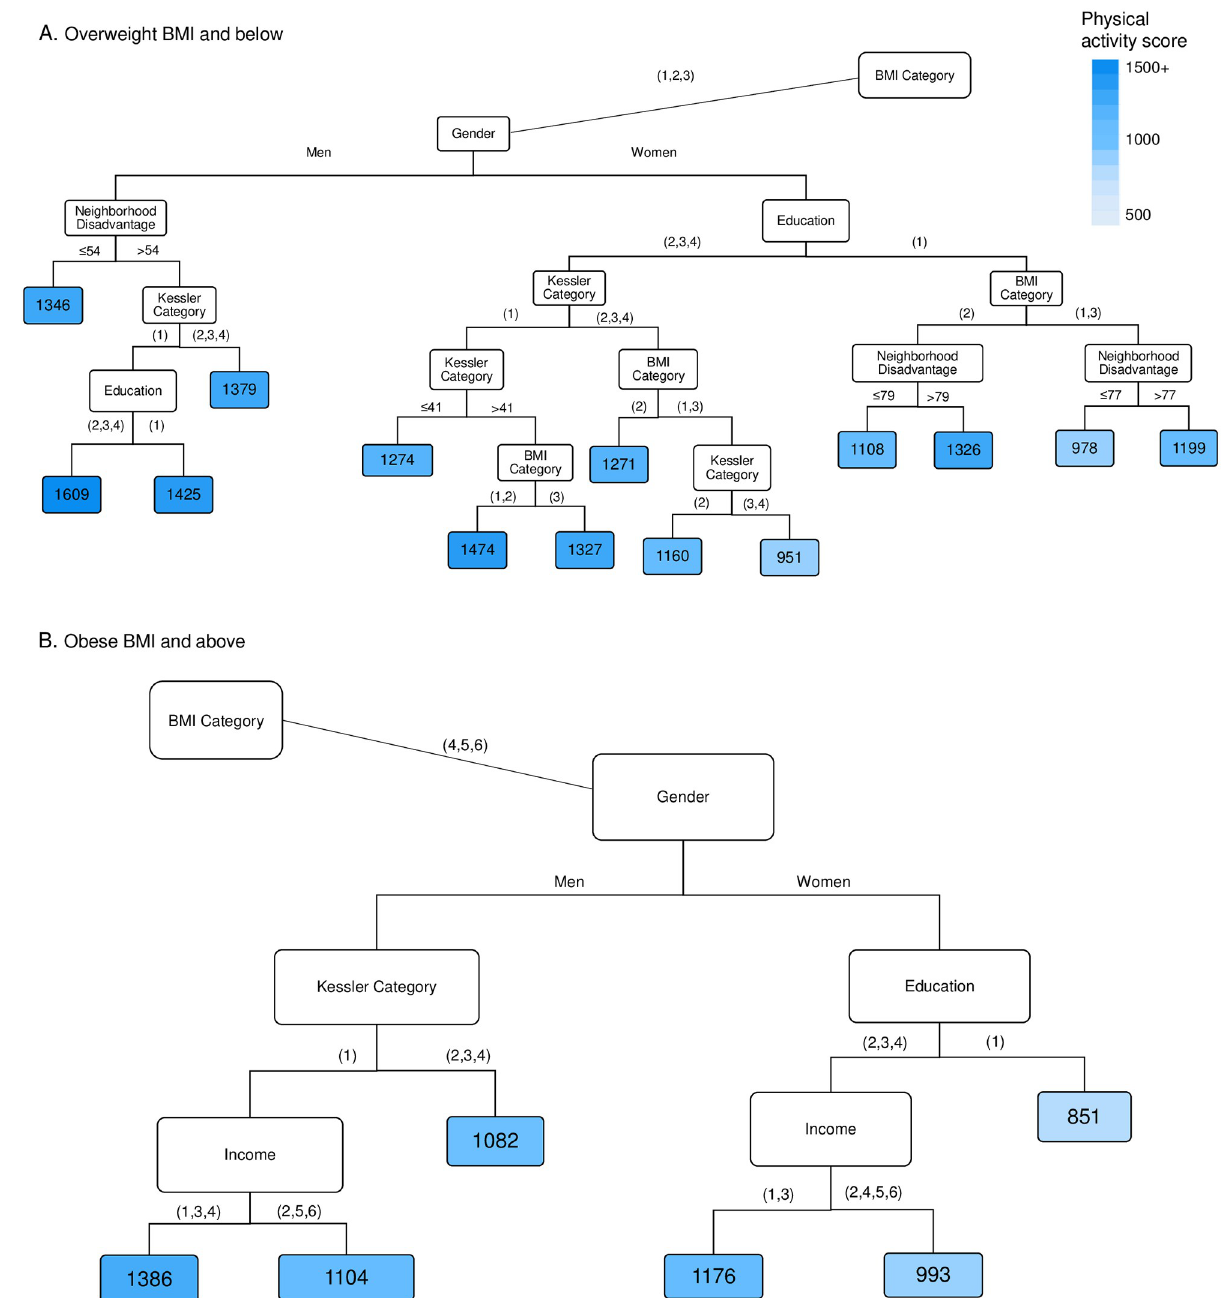
Fig 5. Factors affecting the physical activity for all respondents (n = 7700). The terminal nodes show the average physical activity score in MET.min/ week. Notes: BMI Category (1 = Underweight, 2 = Normal weight, 3 = Overweight, 4 = Obese 1, 5 = Obese 2, 6 = Obese 3); Education (1 = No post school qualification, 2 = Vocational, 3 = Diploma, 4 = Bachelor’s or higher); Kessler Category (1 = Low/none, 2 = Moderate,3 = High, 4 = Very high); Income (1 = < $25,999, 2 = $26,000–51,999, 3 = $52,000–72,799, 4 = $72,800–129,999, � $130,000, 6 = Don’t Know/ Don’t want to answer this). See methods for further details. Predicted Root Mean Square Error per individual and time = 1402 MET mins/week.